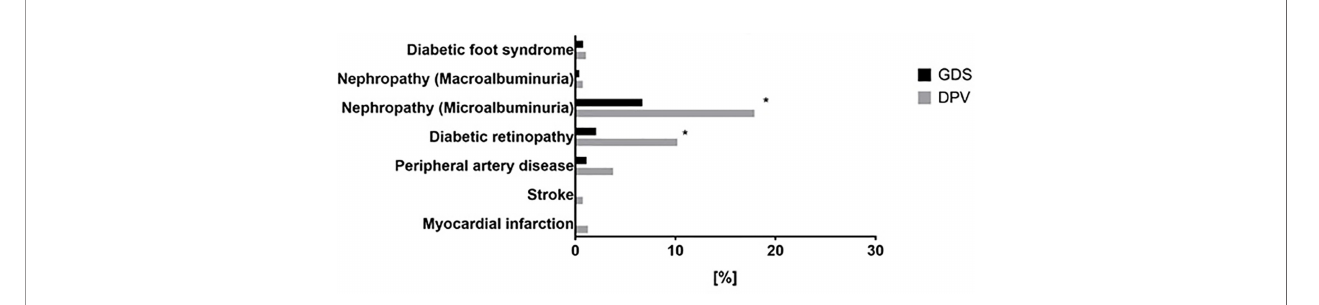
FIGURE 6 | Prevalence of diabetes related complications in patients with newly diagnosed type 1 diabetes from the GDS and DPV cohorts. Prevalence of diabetes- related complications in patients with newly diagnosed type 1 diabetes from the GDS (black) and DPV (grey) cohort. Data was collected on the prevalence of diabetic foot syndrome, diabetic nephropathy (micro- or macroalbuminuria), diabetic retinopathy, peripheral artery disease, myocardial infarction and stroke. Data are expressed as percent from the total number of measured participants in each cohort. P values refer to data adjusted for age, sex, BMI, migration background, hypertension and